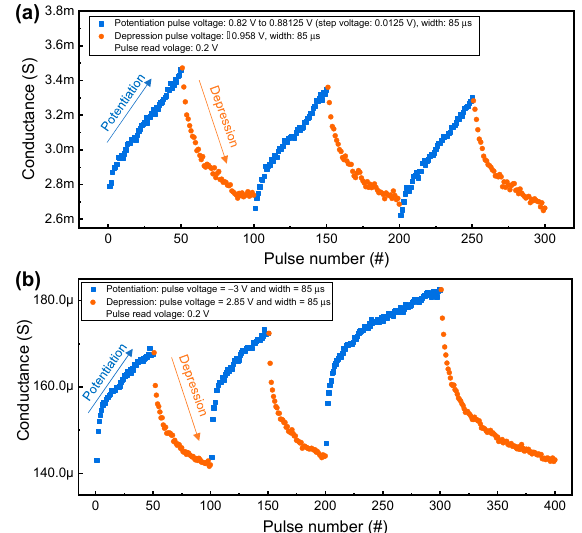
Figure 6. Potentiation and depression characteristics. ( a ) Incremental pulse amplitude increases and identical pulses cause potentiation in the TiN/WO x /Pt device. ( b ) Identical pulse conditions for the TiN/TiO 2 (2 nm)/WO x /Pt device.